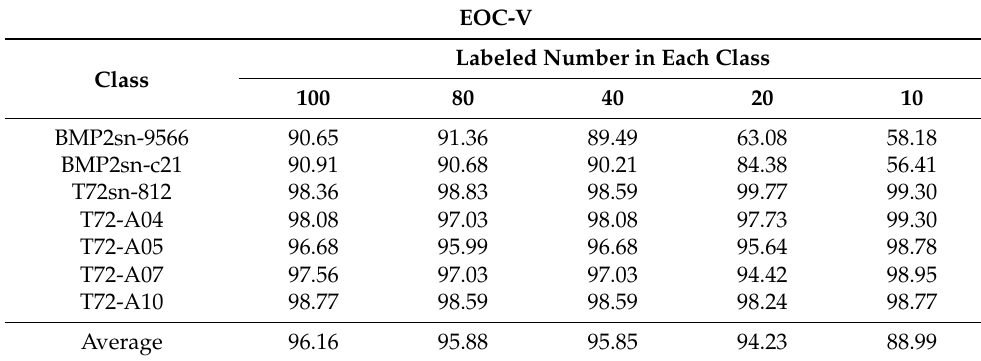
Table 7. Recognition accuracy (%) of EOC-V under different numbers of labeled images in each class.